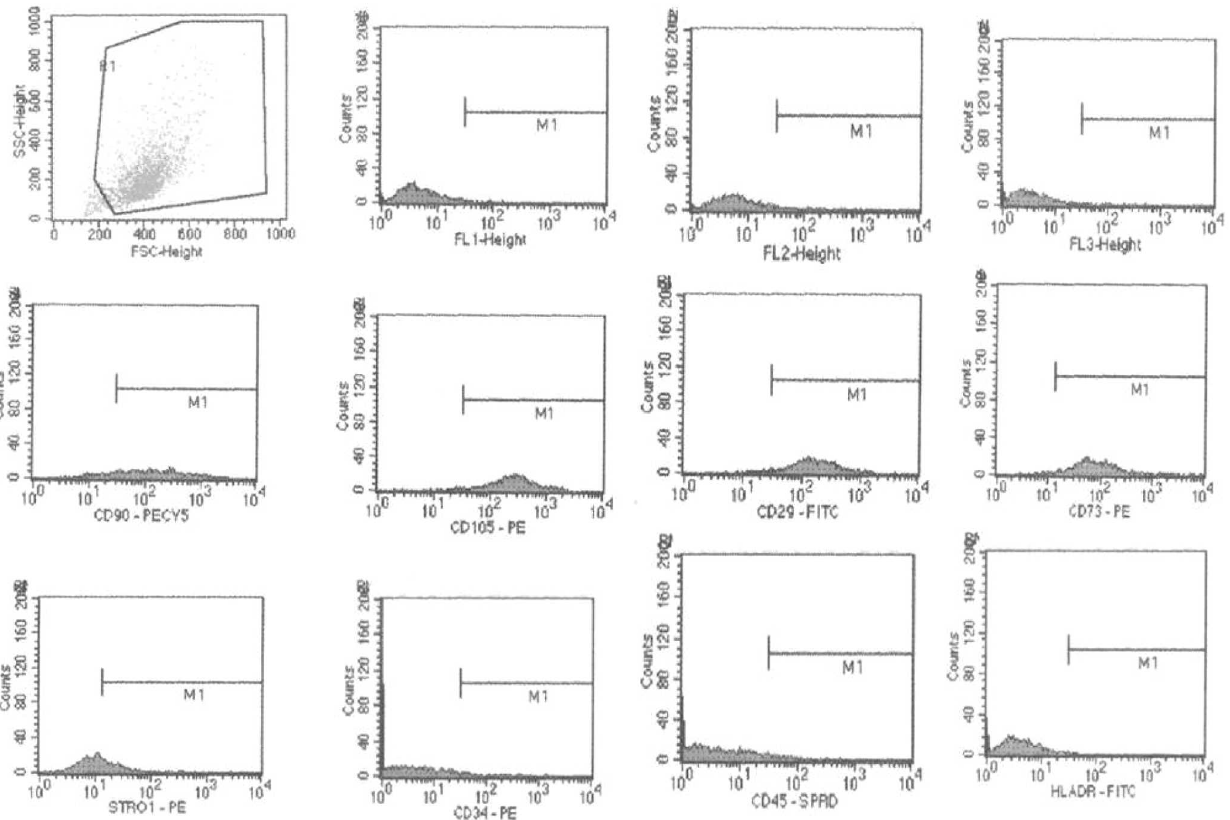
Figure 2 - The expanded cells exhibited cell-surface antigens that are typical of mesenchymal stem and progenitor cells. The results of the immunophenotypic characterization of the PPMCs indicated that the cells were homogeneously positive for the following